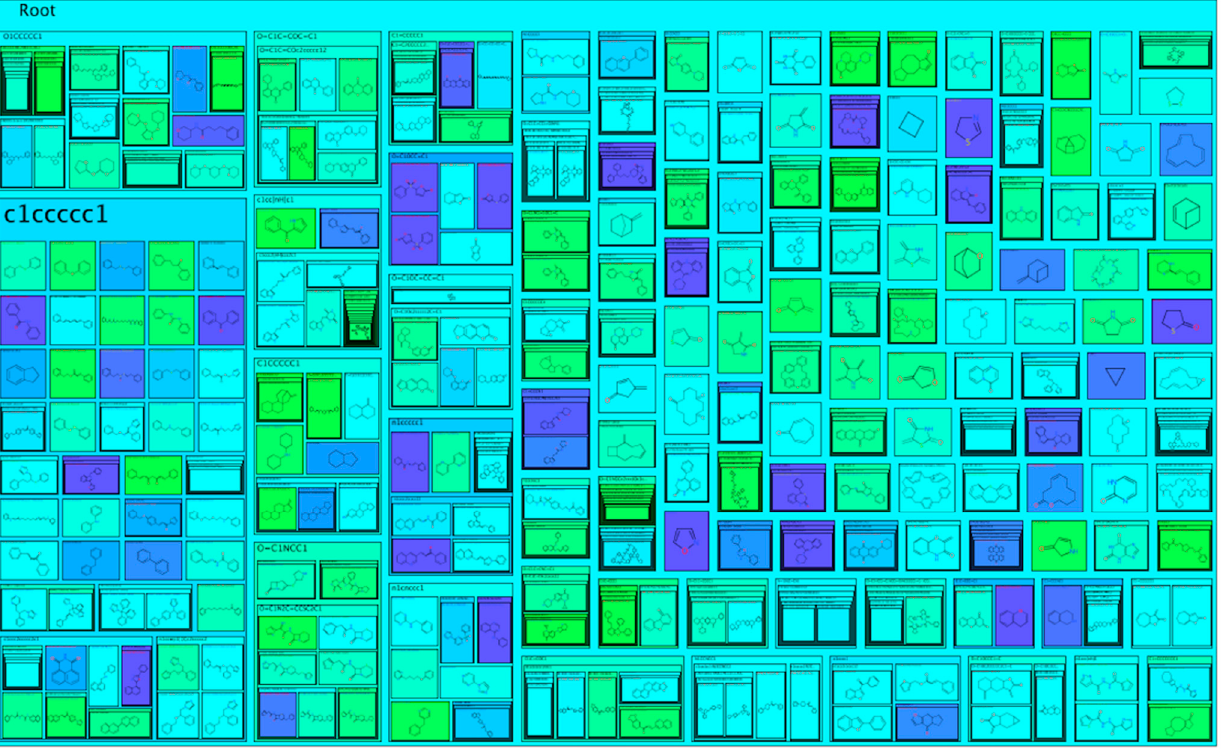
Figure 1. Tree map view of 884 experimentally validated biofilm inhibitors where the value of ECFP4 fingerprint is shown in different colors (yellow color depicts lowest and green color displays highest value).